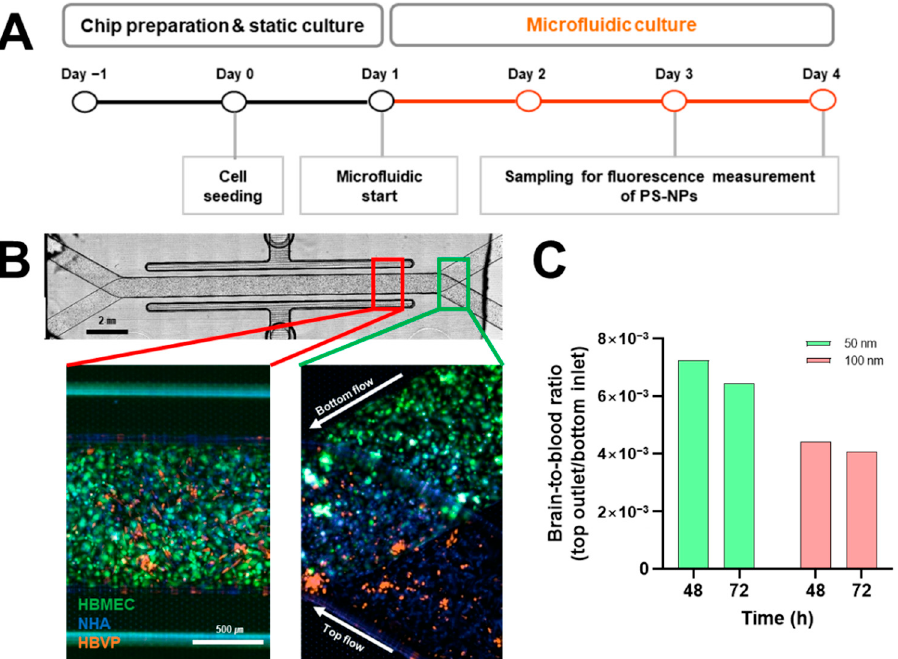
Figure 4. Analysis of polystyrene nanoparticles (PS-NPs) permeability on blood–brain barrier (BBB) chip. ( A ) Experimental scheme of permeability test on BBB chip. Experimental concentration of both PS-NPs was 100 ppm. ( B ) Images of BBB chip and stained cells. ( C ) Test for permeability of two PS-NPs through BBB chip. Brain-to-blood ratio was calculated as relative fluorescence unit (RFU) of outlet chamber in top channel (brain)-to-inlet chamber in bottom channel (blood) ratio. HBMEC: human brain microvascular endothelial cells; HBVP: human brain vascular pericytes; NHA: normal human astrocytes.